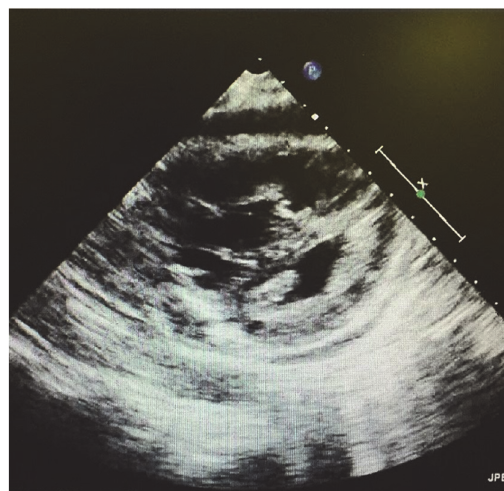
Figure 4: Echocardiogram showing significant dilation of right ventricle along with a slit-like left